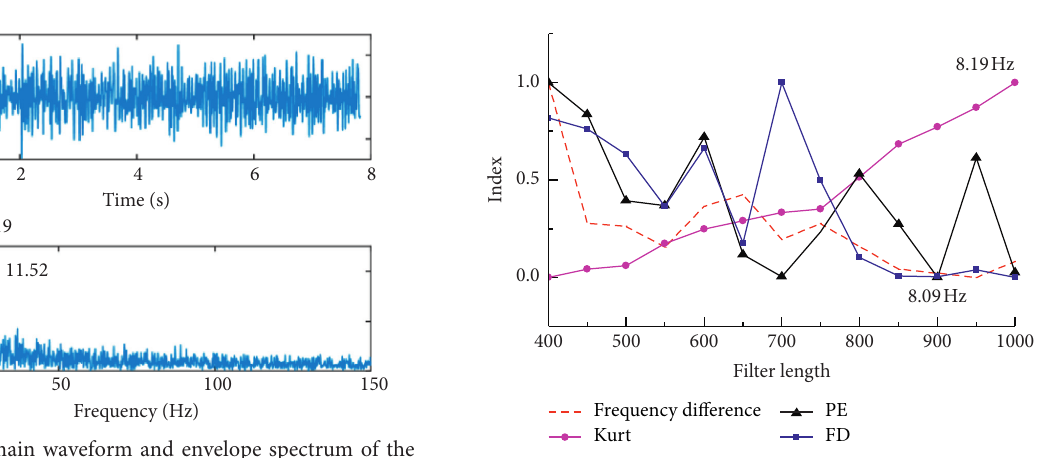
Figure 7: Comparison of different indexes.